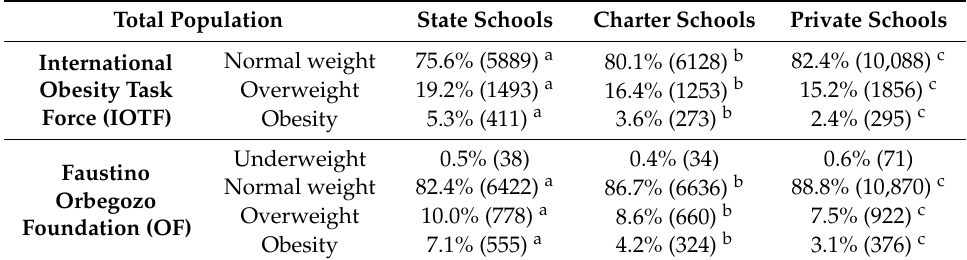
Table 4. Global prevalence of underweight, normal weight, overweight and obesity by school type in the 2010–2019 timeframe.